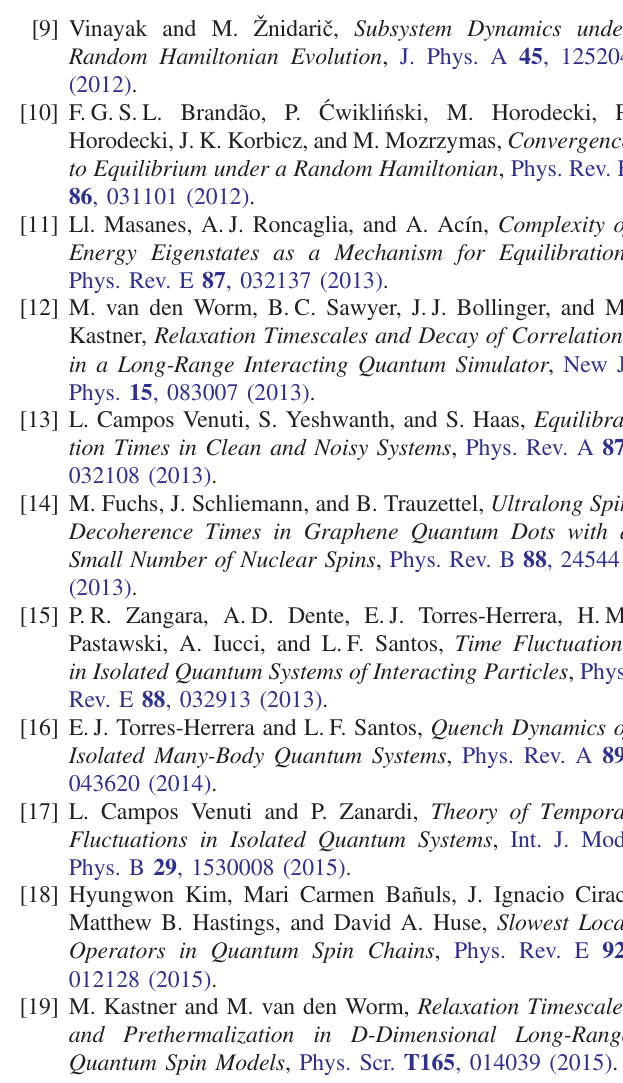
FIG. 5. Plots of average δ ð ϵ Þ and average a ð ϵ Þ and their respective standard deviations (after 1000 realizations) for an observable σ z ⊗ ⨂ L 1 ρ 1 ih 1 j ⊗ ⨂ L 1 2 , for a spin ring with random couplings K A λ and initial state 0 ¼ j λ = 1 λ ¼ 2 λ ¼ 2 z ¼ deviation w ¼ 0 . 2 Ω . Once again, both a ð ϵ Þ and δ ð ϵ Þ decrease as L increases, for a fixed energy gap interval ϵ . Hence, as L increases, it becomes possible to find ϵ such that a ∼ 1 and δ ≪ 1